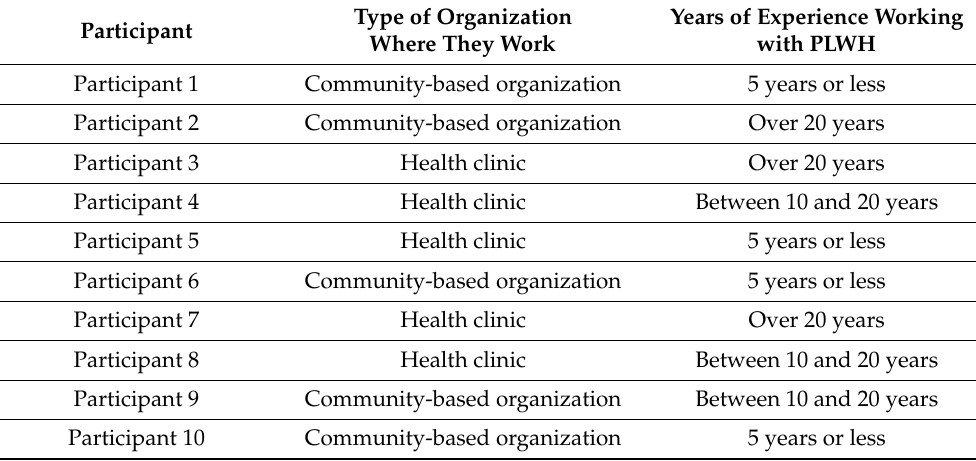
Table 2. Participants’ type of organization and years of experience working with people living with HIV